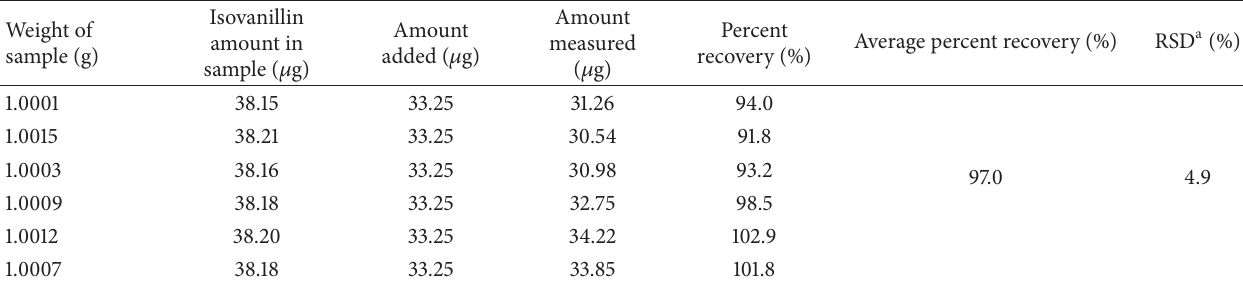
Table 2: Percent recovery of